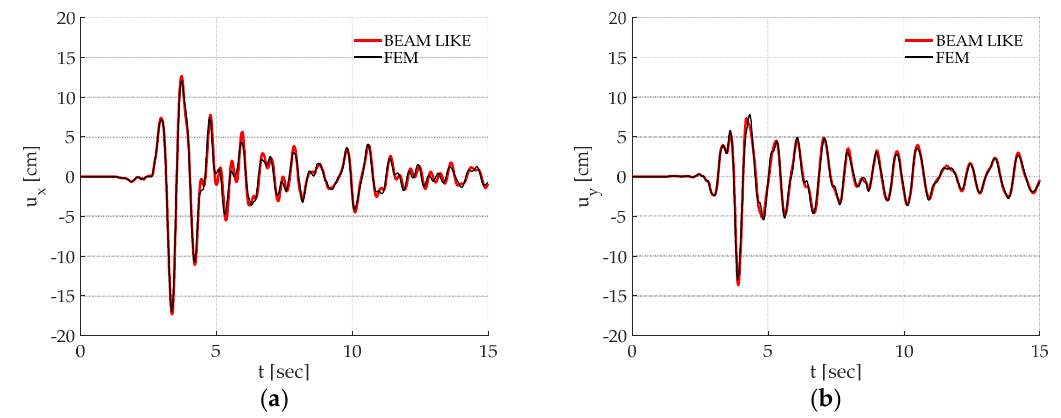
Figure 14. Eight-storey benchmark. L’Aquila earthquake. Displacements time history along the ( a ) x and ( b ) y direction.